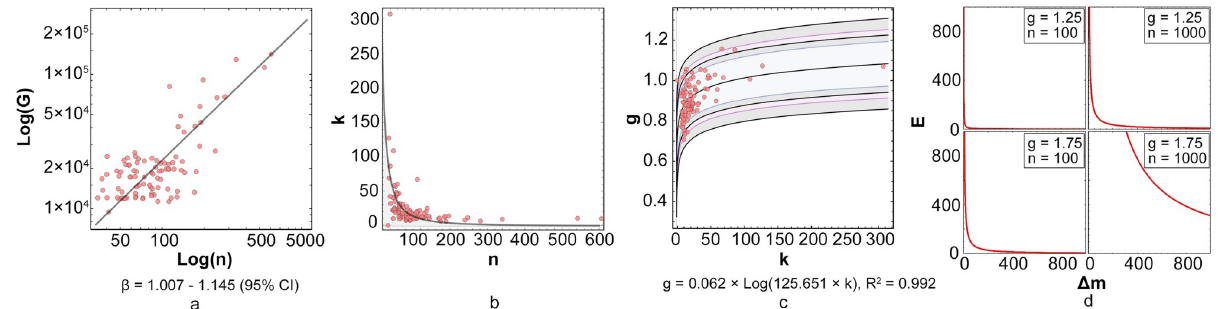
Fig 4. Relation of internal node layout rules by urban power law. Plot of a) urban–rural income gap and population, b) k value and population, c) conversion rate k of the mode and power coefficient g , and d) function under two different Δ n and g .